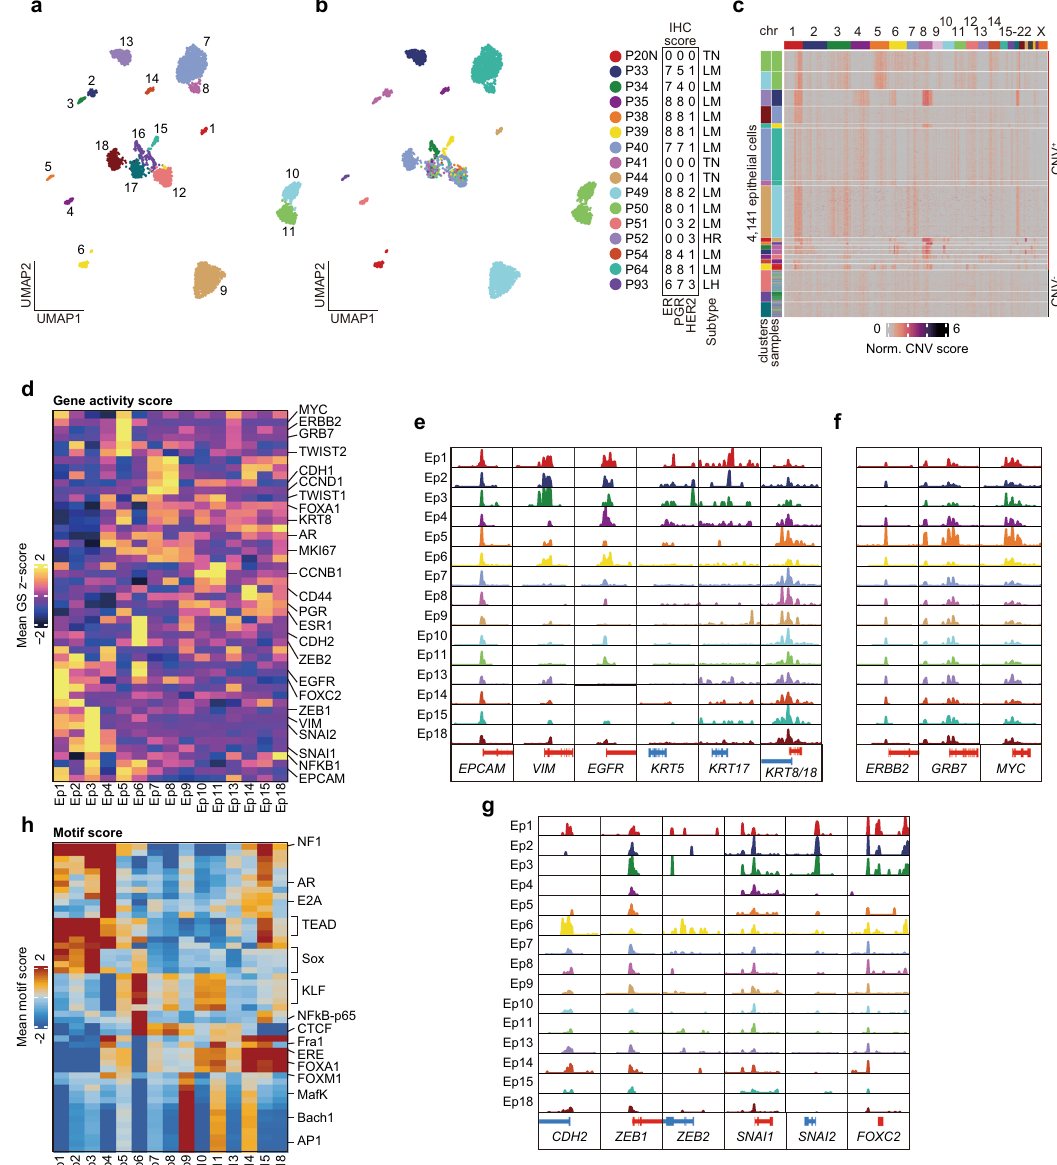
Fig. 2 Chromatin landscape of breast cancer cells. a , b UMAP of subclustering of 4141 epithelial cells, colored according to corresponding epithelial clusters in a and corresponding patients in b . In a , cluster number is shown on the UMAP. Sample details shown to the right of b are identical to those shown in Fig. 1b. c Inferred copy number variations of 4141 epithelial cells from scATAC-seq data. The log2(fold change) to GC-matched background was calculated and normalized by the same scores for TME cells. Clusters and samples of each cells were represented on the left side of the heatmap. d Heatmap of Z -score of marker gene activity score. e – g Aggregated ATAC signal tracks showing chromatin accessibility peaks of approximate transcription start sites of luminal or TNBC markers in e , HER2 associated genes in f , and epithelial to mesenchymal transition markers in g for each cancer cluster. h Most variable 50 TF motif scores for each cancer